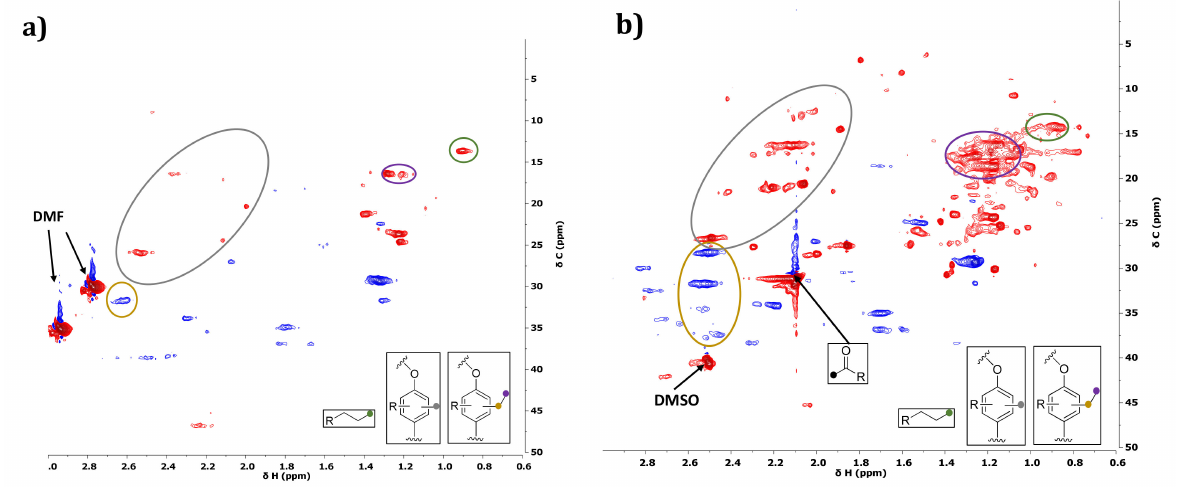
Figure 16. Side-chain region (non-oxygenated) of HSQC NMR spectra of initial ( a ) and organic phase after reaction without catalyst in water/EtOH ( b